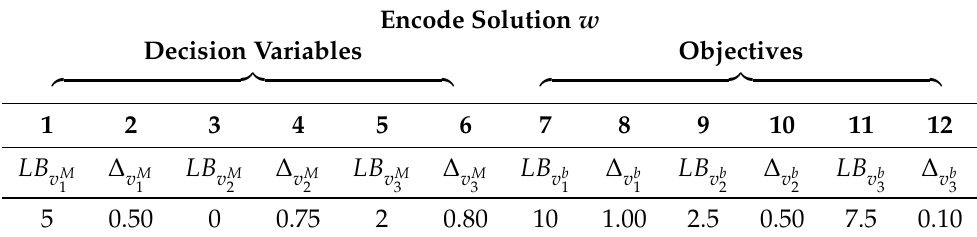
Table 3. Proposed solution’s encoding for MOFBA. Encode Solution w Decision Variables